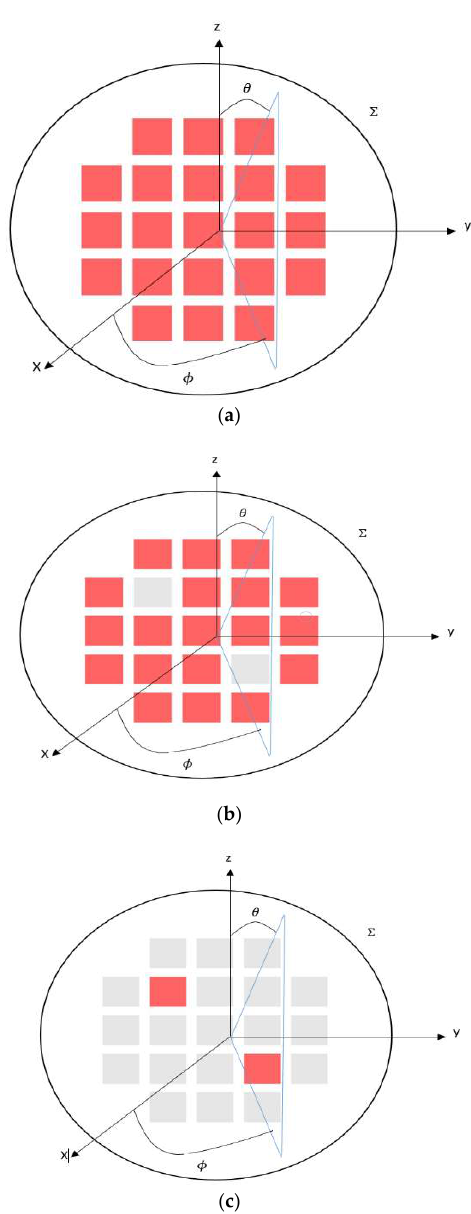
Figure 2. Antenna array: ( a ) reference antenna without failures; ( b ) antenna under test (AUT); ( c ) differential antenna (DA). The number of failures is 2 within the total element number N = 21 .